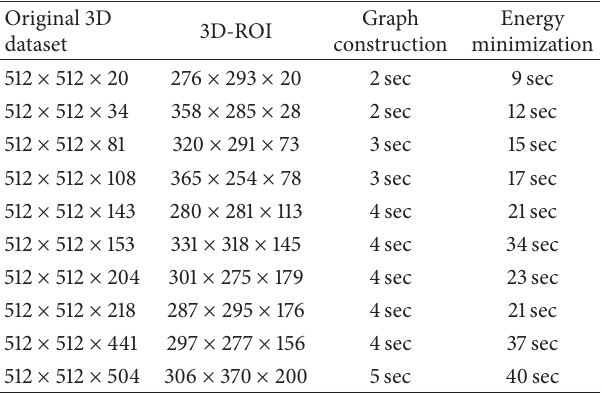
Table 1: Experimental results on